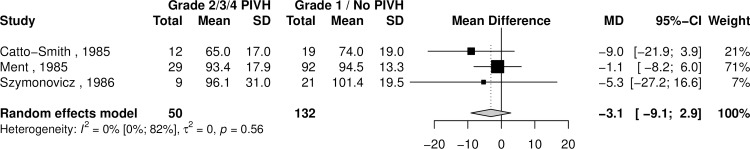
Absolute mean difference of mental development index between children with no or grade 1 peri-intraventricular haemorrhage (PIVH) and children with higher degrees of PIVH.